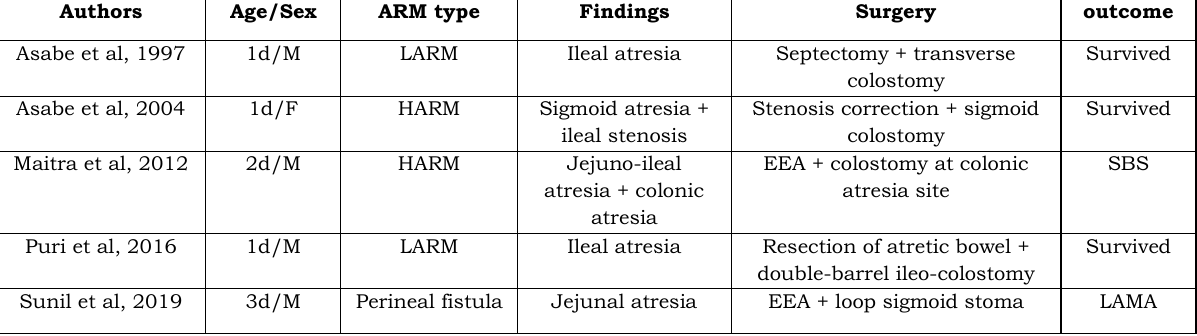
Table 1: Showing Published cases of anorectal malformations associated with small bowel